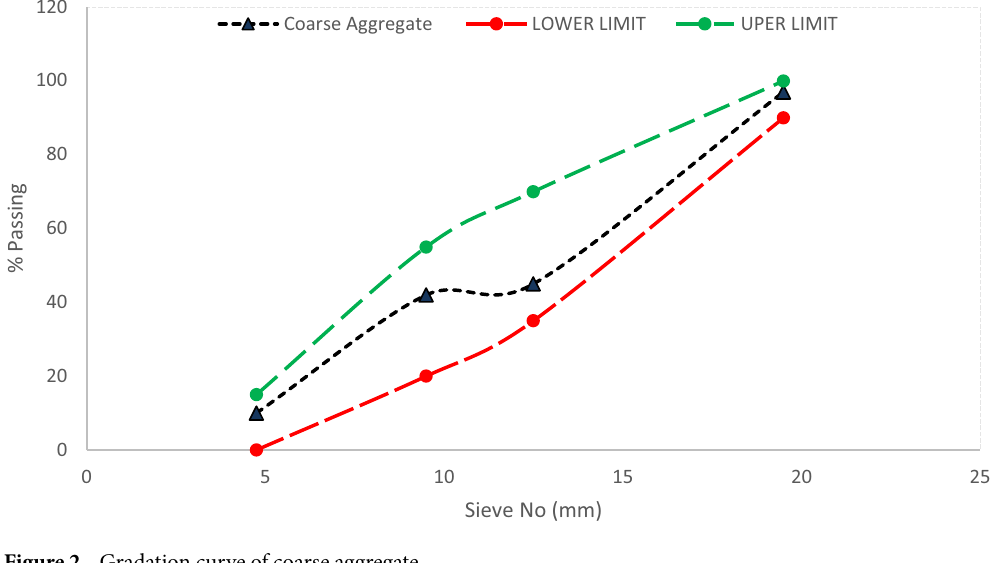
Figure 2. Gradation curve of coarse aggregate.